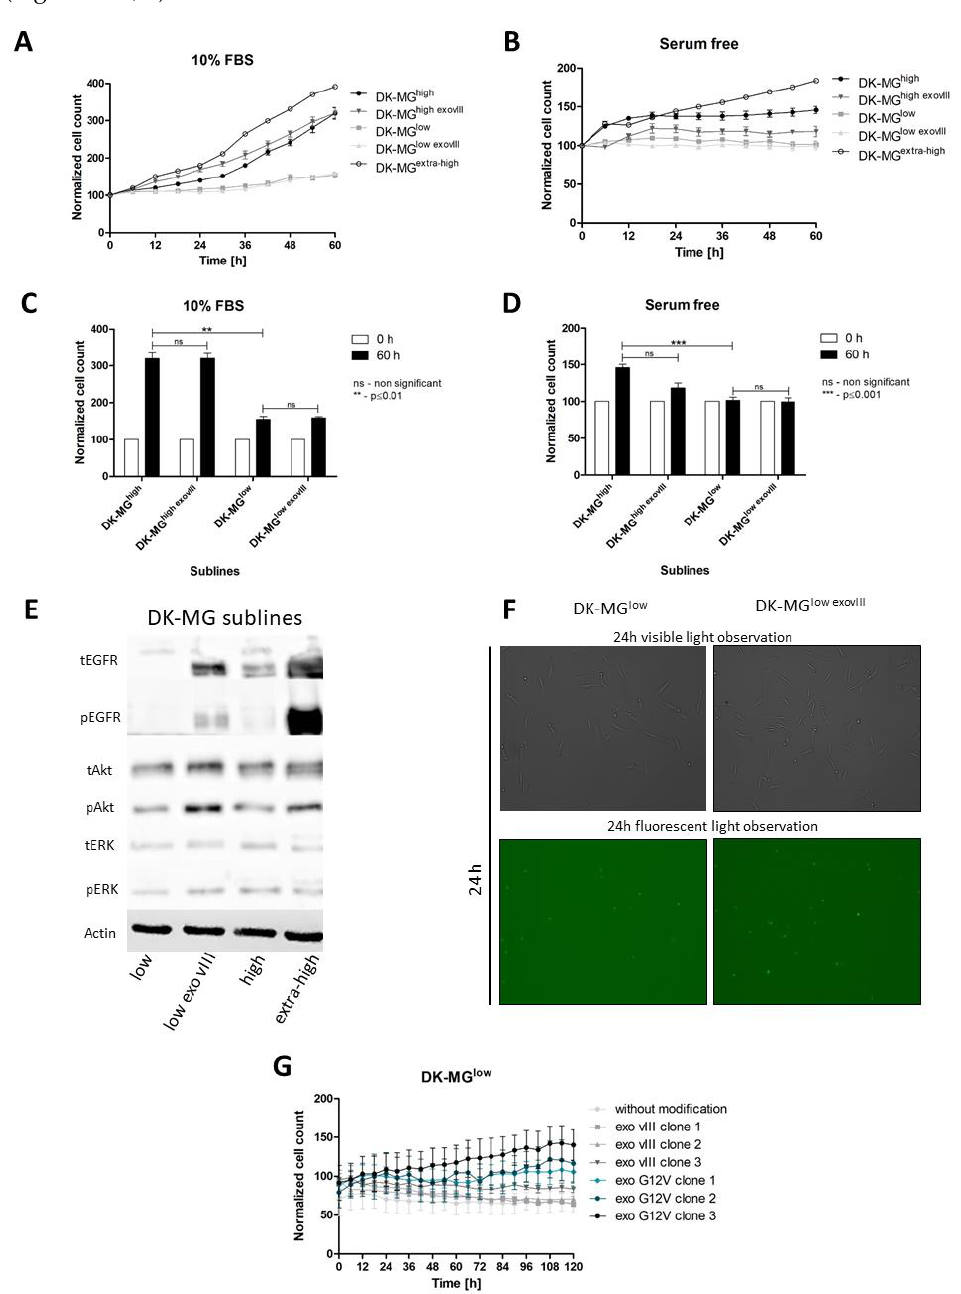
Figure 2. Influence of exogenous EGFR vIII expression on the DK-MG subline status. Incorporation of EGFR vIII into the DK-MG high or DK-MG low cell line did not significantly change their proliferation ratio in either full medium ( A ) or serum-free conditions ( B ) in statistically significant way ( C , D ). ( E ) The DK-MG low cells regained an aggressive DK-MG high phenotype following induction by exogenous K-RAS G12V with no lack of rescue observed after EGFR vIII transgene introduction. The lentiviral clones differed from each other by increasing virus titers for both EGFR vIII and K-RAS G12V . No differences were found between DK-MG sublines with regard to the phosphorylation level of the downstream proteins in the EGFR transduction pathways; magnification 100 × ( F ). Exogenous expression of EGFR vIII in DK-MG low was insufficient for avoiding spontaneous cell death ( G